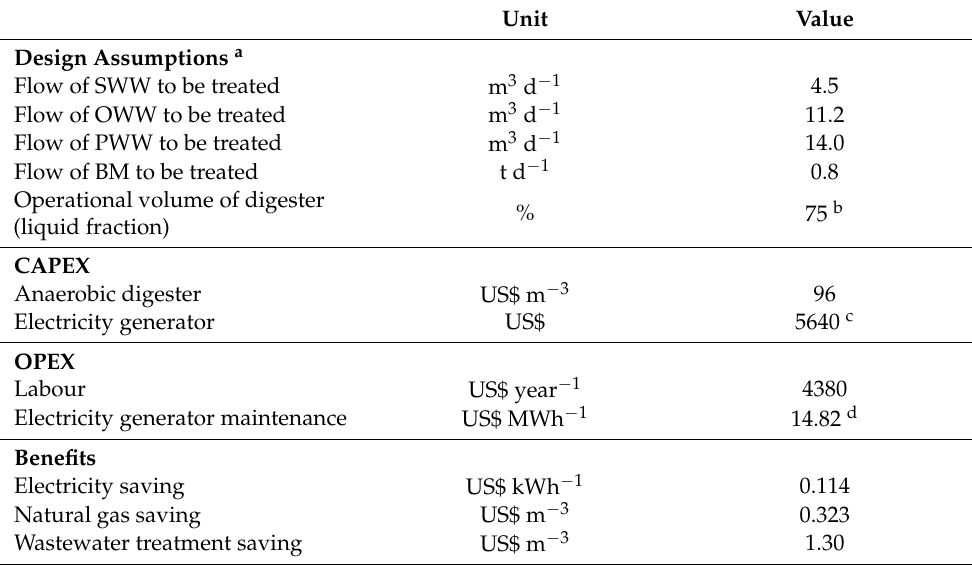
Table 5. Parameters and assumptions for the economic